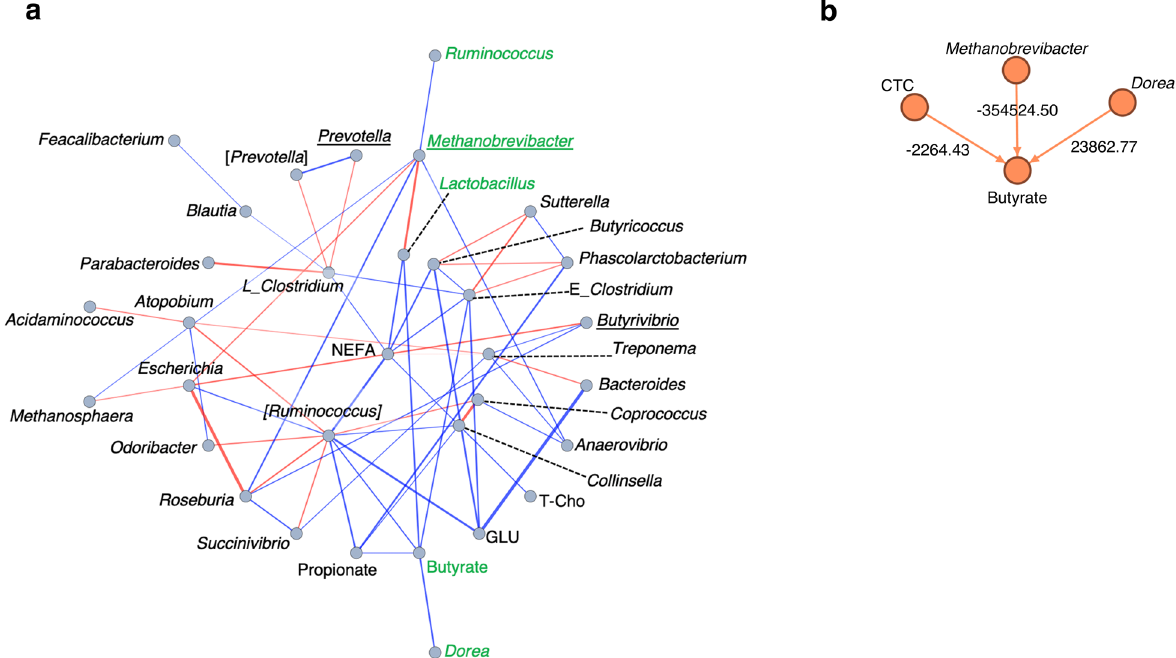
Figure 5. ( a ) The ELA interaction network shows the significant relationships in the extended pairwise maximum entropy model fitted to the observational data. Components were selected by linear discriminant analysis and association analysis. The bacteria selected by both analyses are underlined. The blue and red lines show positive and negative relationships, respectively. The abbreviations are as follows: E: family Erysipelotrichacea e; L: family Lachnospiraceae ; GLU: serum glucose; NEFA: serum nonesterified free fatty acid; butyrate: fecal butyric acid; propionate: fecal propionic acid; T-Cho: serum total cholesterol. ( b ) The calculated causal relationship of the components strongly linked with butyrate is visualized by linear non-Gaussian acyclic model (DirectLiNGAM) analysis. The amounts of change (d 3, 30, and 60) with respect to the values at d 3 of the components aligned with butyrate (green letters) ( a ) were used for the calculation. The arrow shows the trend of the causal relationship. The number shows the value of the causal contribution calculated by the DirectLiNGAM analysis. The minus and plus values show negative and positive causal contributions,